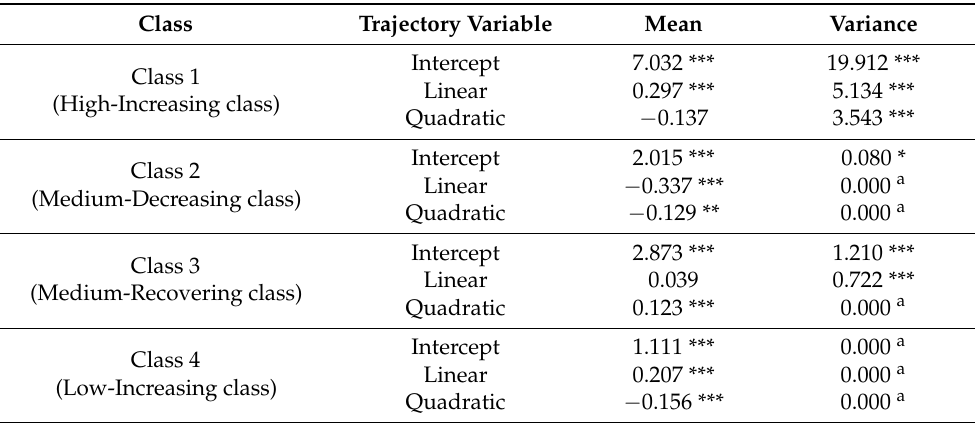
Table 4. Parameter estimation of latent growth factors for the 4-class GMM.